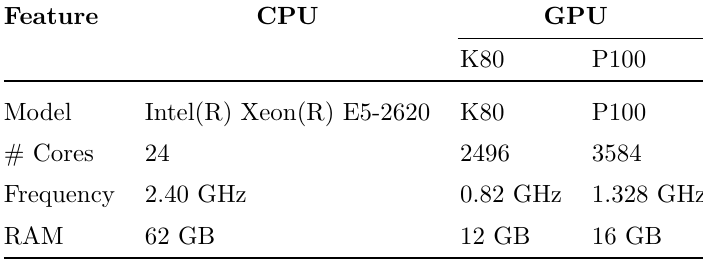
Table 3: Testbed environment hardware configurations.